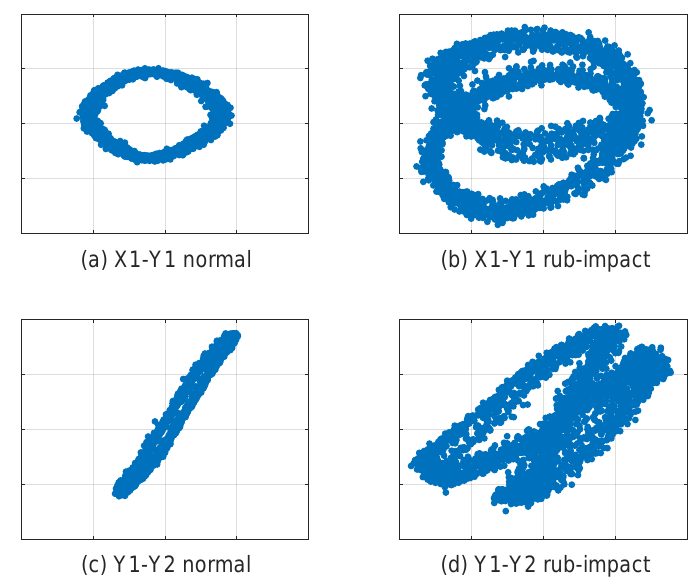
Figure 4. Typical vibration images created by different channel